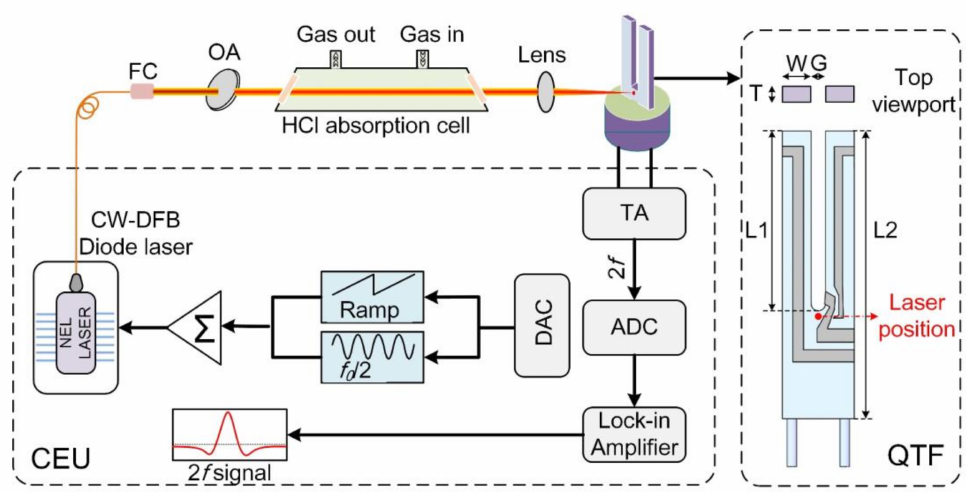
Figure 2. Schematic diagram of the experimental setup. FC, fiber collimator; OA, optical attenuator; TA, trans-impedance amplifier; ADC, analog-to-digital converter; DAC, digital-to-analog converter; CEU, control electronics unit. L1 = 3.9 mm, L2 = 5.4 mm, W = 0.62 mm, T = 0.36 mm, and G = 0.32 mm. The red dot indicates the optimum position for the laser beam on the QTF in